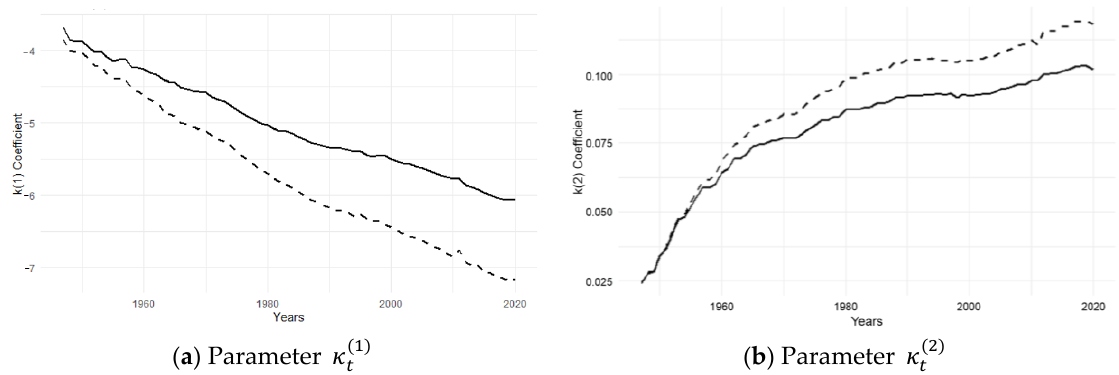
Figure 5. Japan’s CBD model for both male (solid line) and female (dashed line).